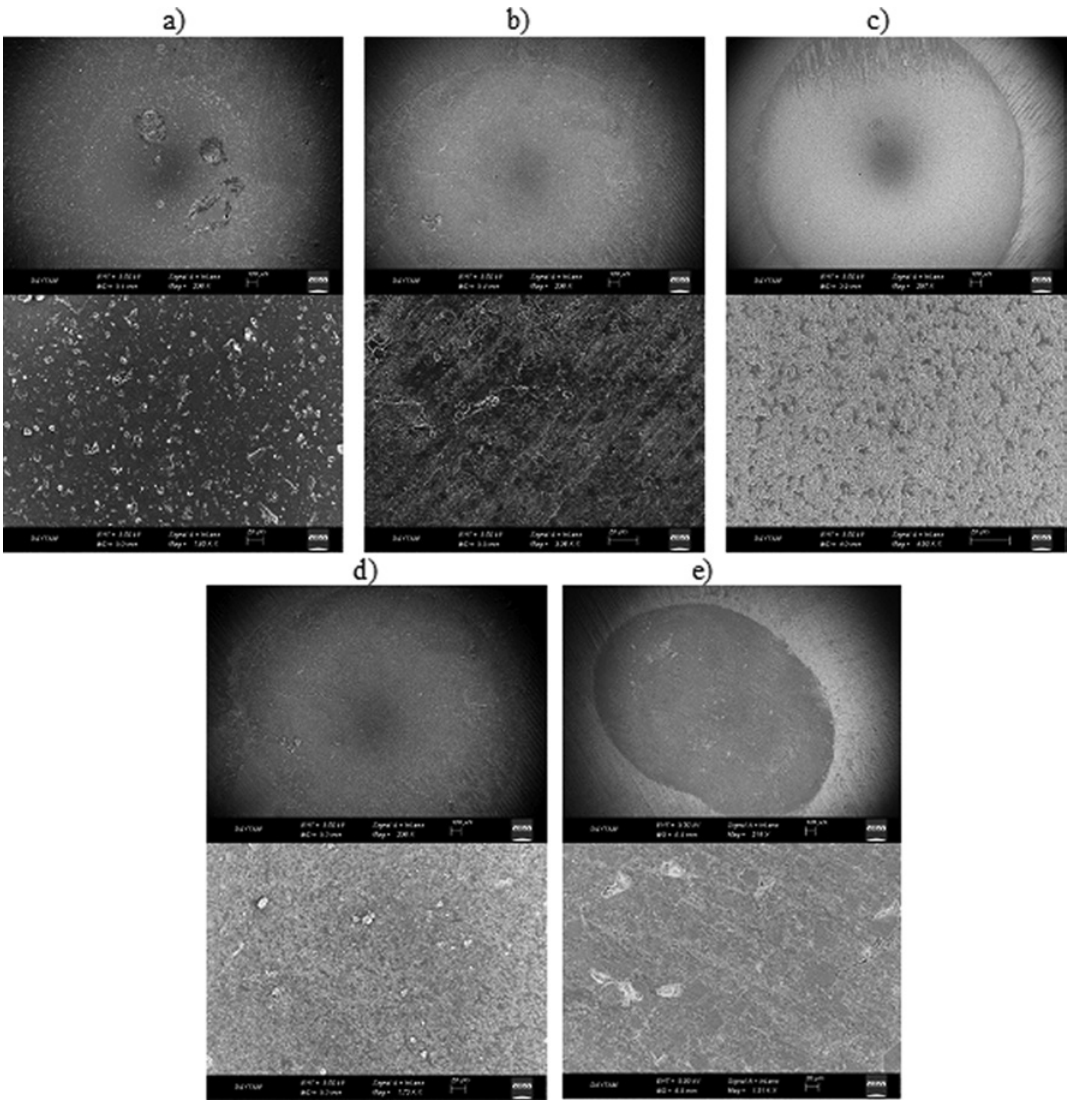
Figure 4: SEM images of the worn surface of composite resines tested after 480,000 mastication cycle tests (A: Clearfil AP-X, B: Filtek Z250, C: Kalore, D: Filtek Supreme XT, and E: